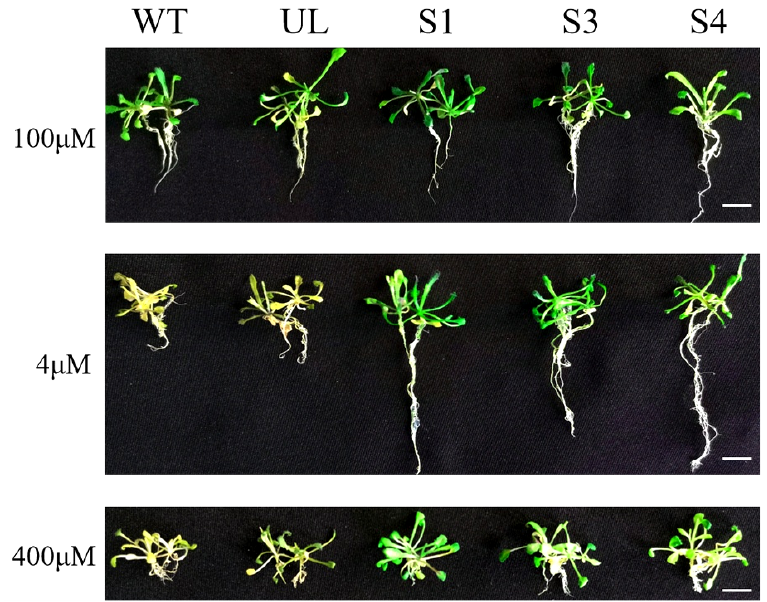
Figure 7. Overexpression of MxbHLH18 in A. thaliana improved Fe stress tolerance. Phenotypes of MxbHLH18 transgenic A. thaliana lines (S1, S3, S4), WT and UL under on normal Fe level (100 μ M), low Fe level (4 μ M) and high Fe level (400 μ M). Scale bar corresponds to 1 cm.